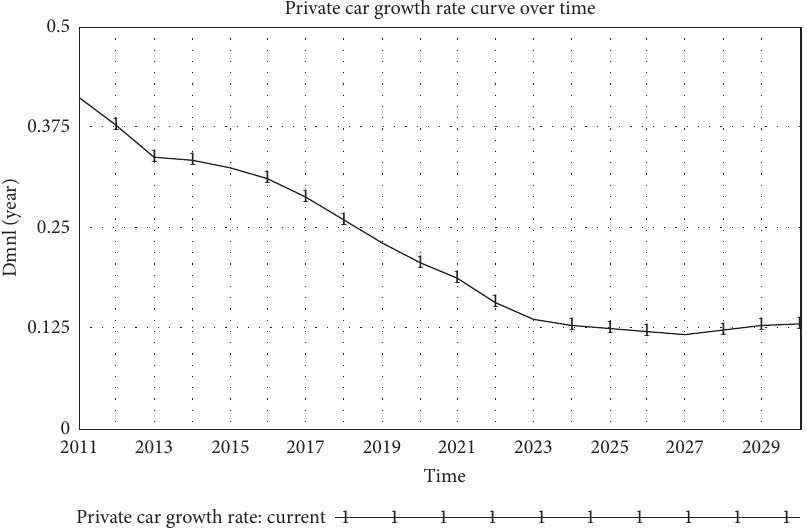
Figure 8: Changes in the growth rate of private cars.